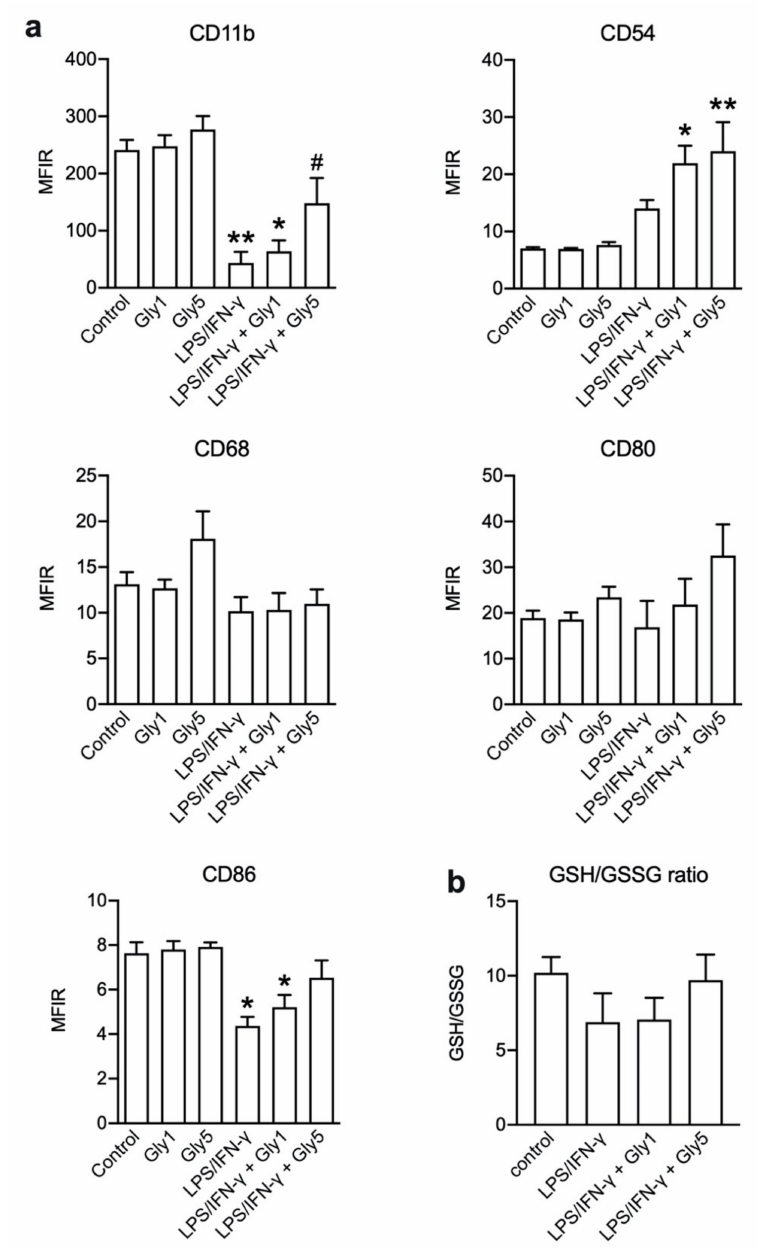
Figure 5. ( a ) Median fluorescence intensity ratios (MFIR) of CD11b, CD54, CD68, CD80 and CD86 staining in BV-2 cells without treatment (control) and treated for 24 h with 1 or 5 mM glycine (Gly1, Gly5) or for 24 h with LPS / IFN- γ in the absence and presence of 1 or 5 mM glycine (Gly1, Gly5), respectively. Asterisks indicate significances compared to control (* p < 0.05; ** p < 0.01); the hash indicates significance compared to LSP / IFN- γ treatment (# p < 0.05). Six independent experiments were performed per treatment. ( b ) Reduced glutathione / oxidized glutathione (GSH / GSSG) ratios measured under the same conditions as in (a). Three independent experiments were performed per